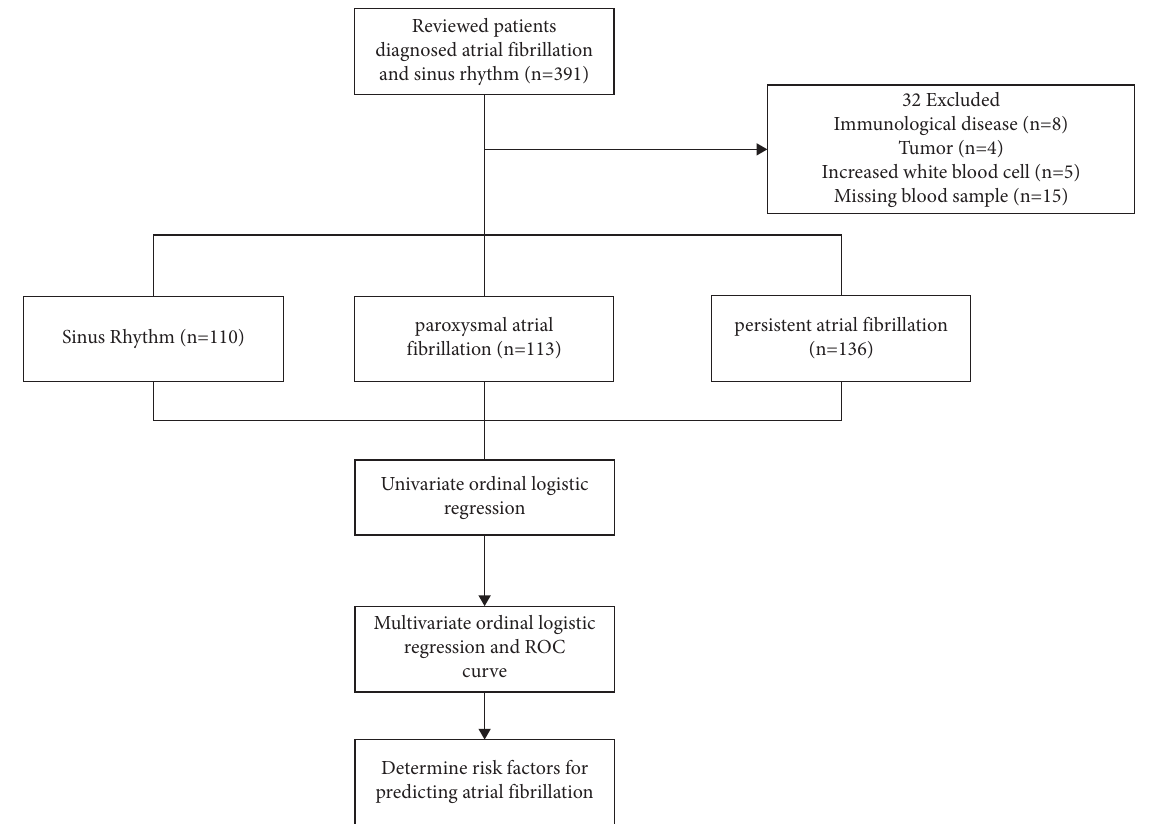
Figure 1: Patient selection